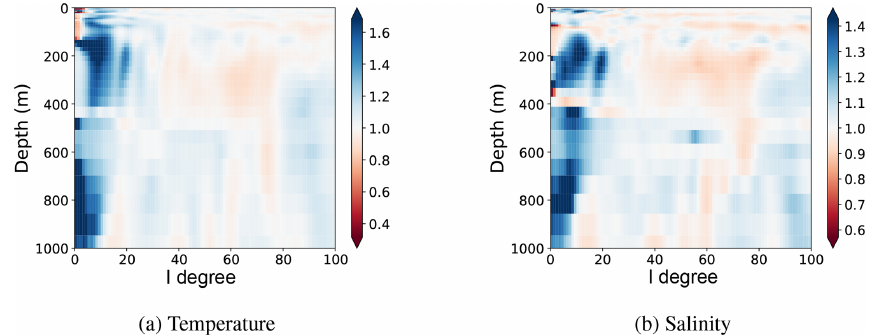
Figure 13. Improvement obtained by the multiscale analysis for temperature (a) and salinity (b) . This improvement is measured by com- parison to spatial localisation only using the ratio in Eq. (16). Blue (respectively red) colour corresponds to a better (respectively worse) correction of the error using the multiscale analysis as compared to spatial localisation